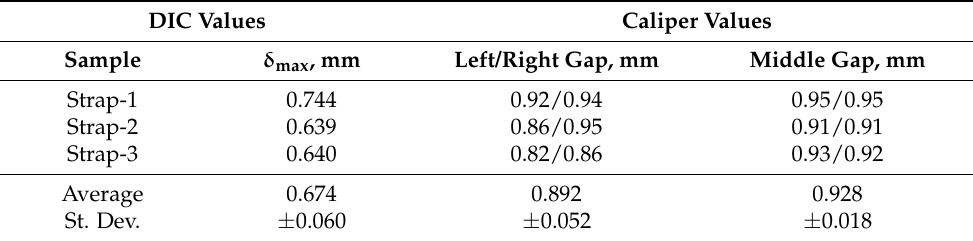
Figure 15. Load vs. (DIC) displacement curves for straps loaded up to 0.1 F max . Table 5. Maximum displacement values obtained with DIC and